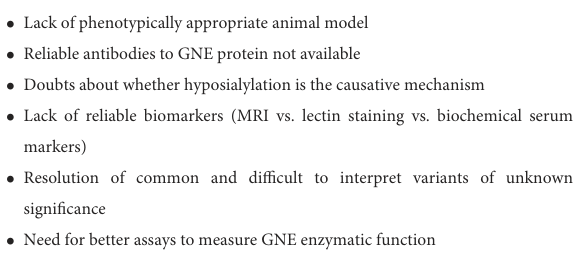
TABLE 3 Areas for future study—Unmet needs in GNE